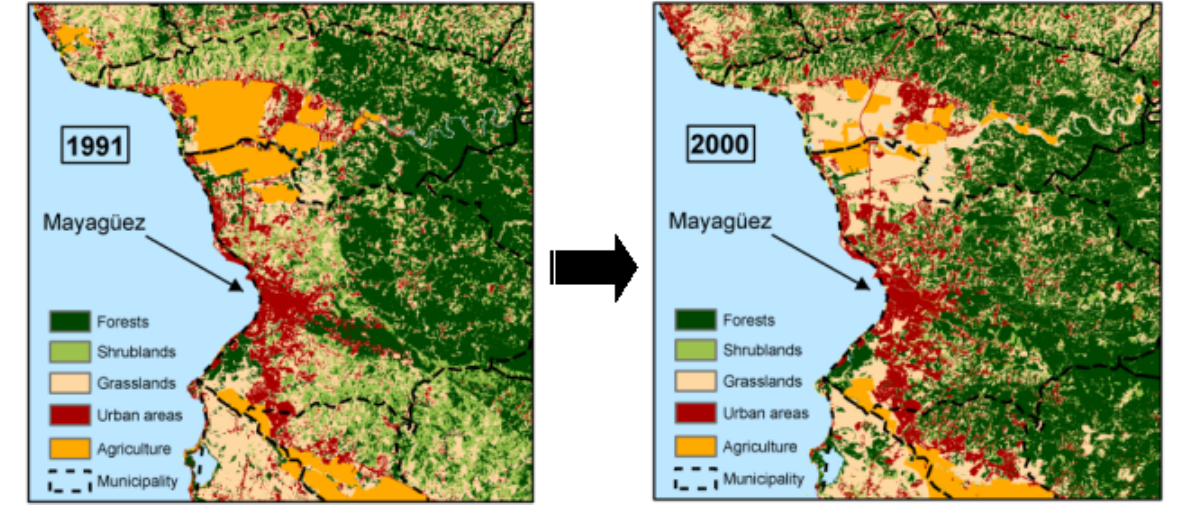
Fig. 4. Land-cover changes between 1991 and 2000 around the city of Mayagüez in western Puerto